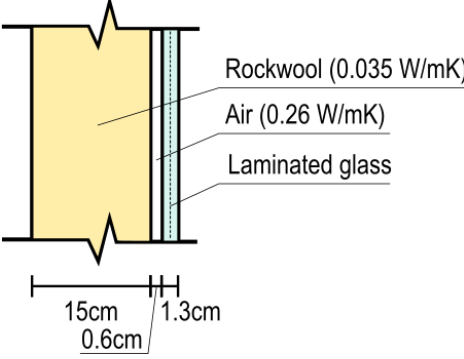
Figure 1. Build-up of analyzed spandrel.